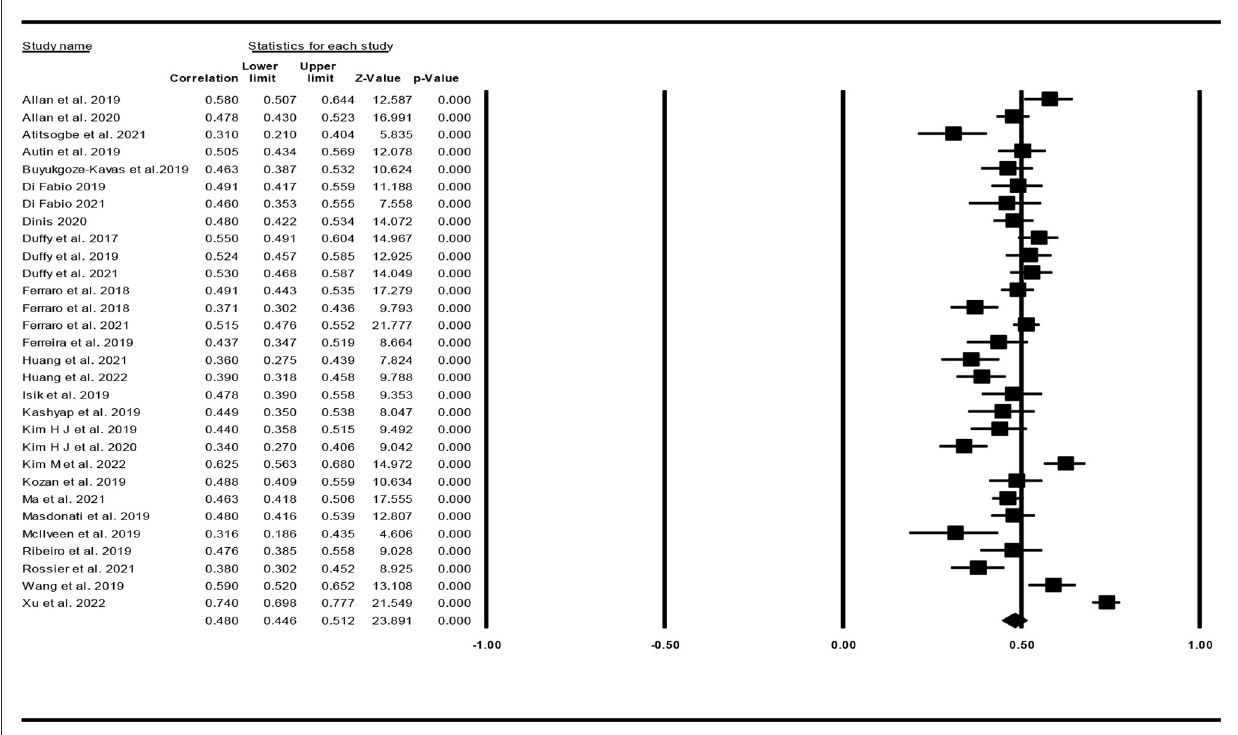
FIGURE2 Effect sizes of each study regarding the association between decent work and wellbeing.